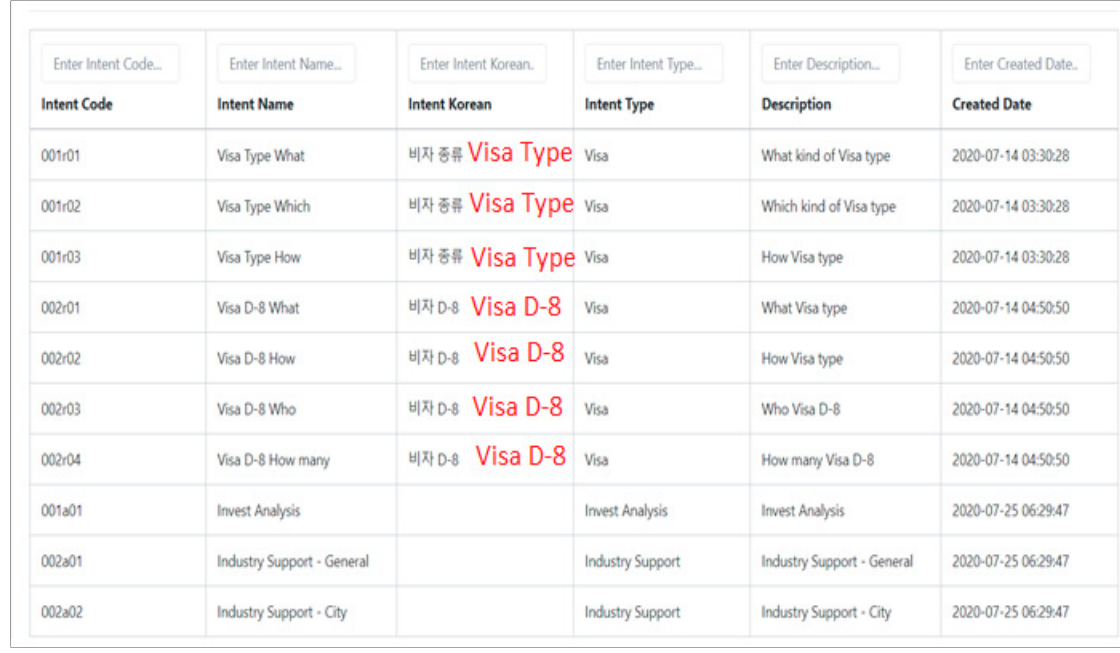
Figure 14. Data set sample of Intent.